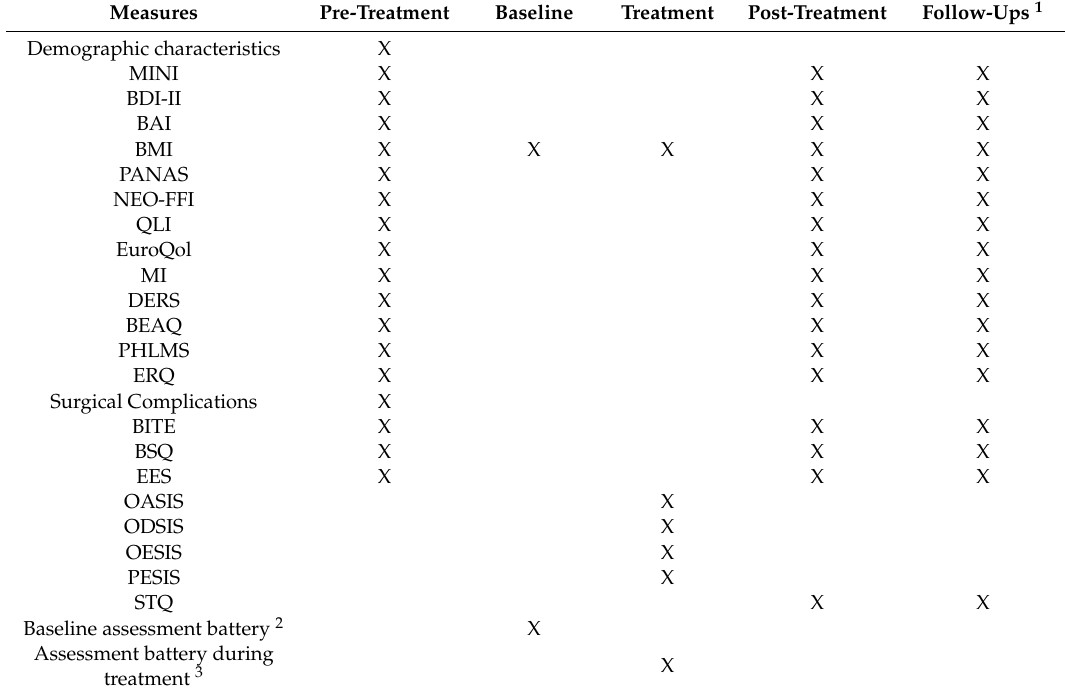
Table 3. Distribution of the variables administered throughout the intervention.